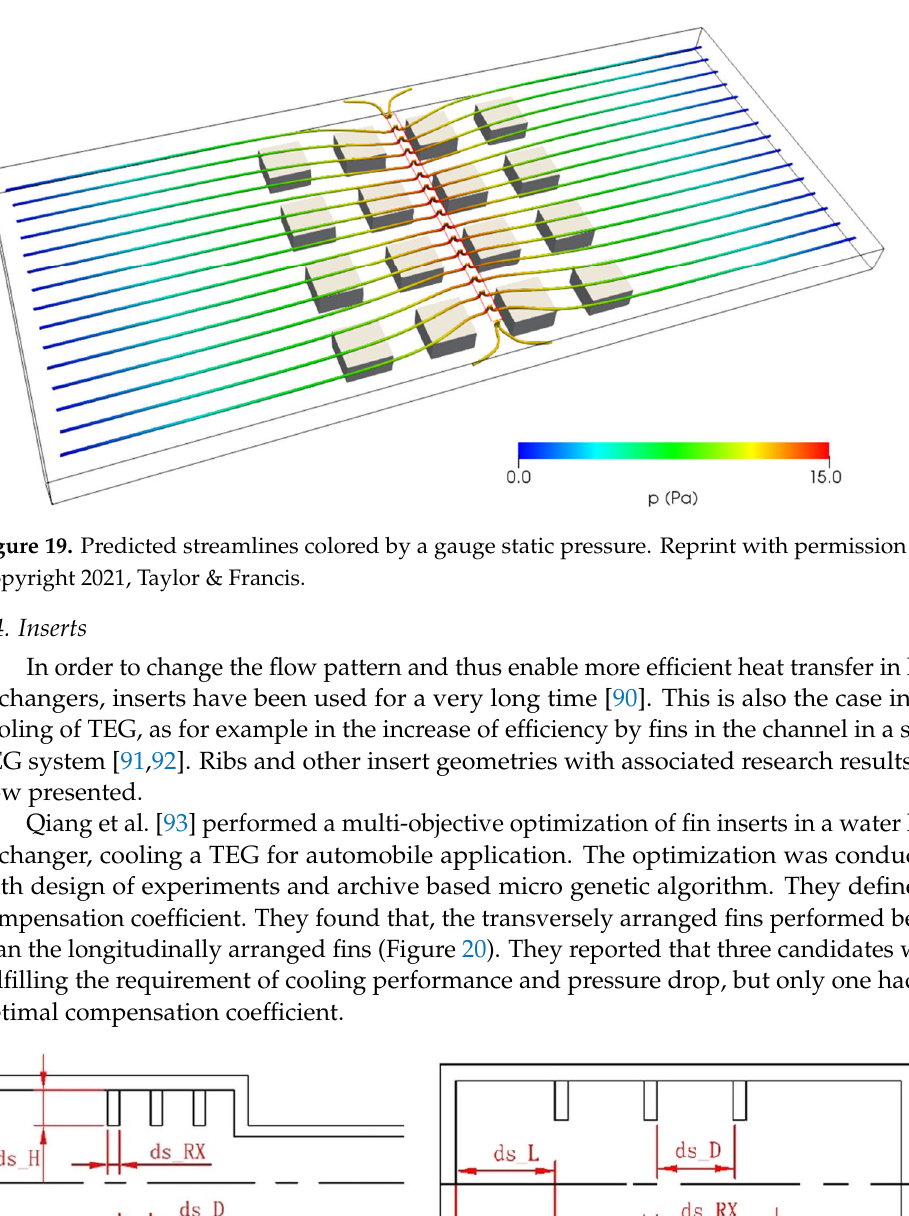
( b ) Figure 18. Cold side impingement jet geometry of a automotive TEG system ( a ) Front View; ( b ) Isometric View. Reprint with permission [87]; Copyright 2021, Dr. Pandit. Pfeiffelmann et. al. [88,89] reported a new solver within an open source CFD frame- work to model a TEG and the flow of the heat exchanger at once. Two ingredients of the